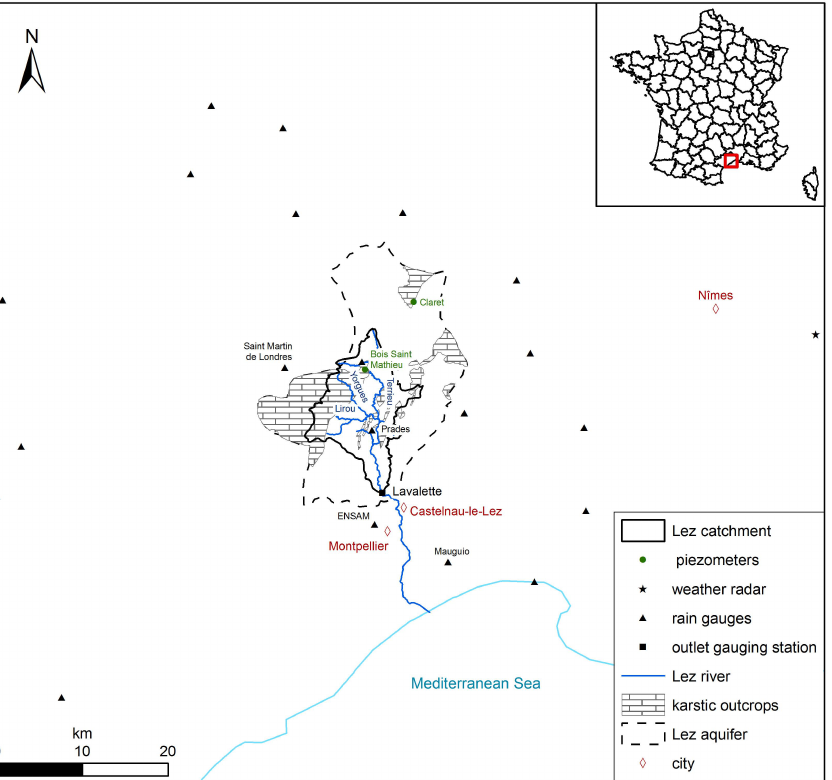
Fig. 1. Visualisation of the Lez catchment and its monitoring network: map of the Lez catchment, the rain gauges used for the measurement of ground rainfall, and the Nˆımes weather